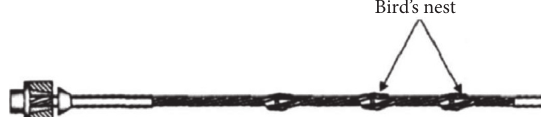
Figure 8: Structural sketch of bird’s nest anchor cable.